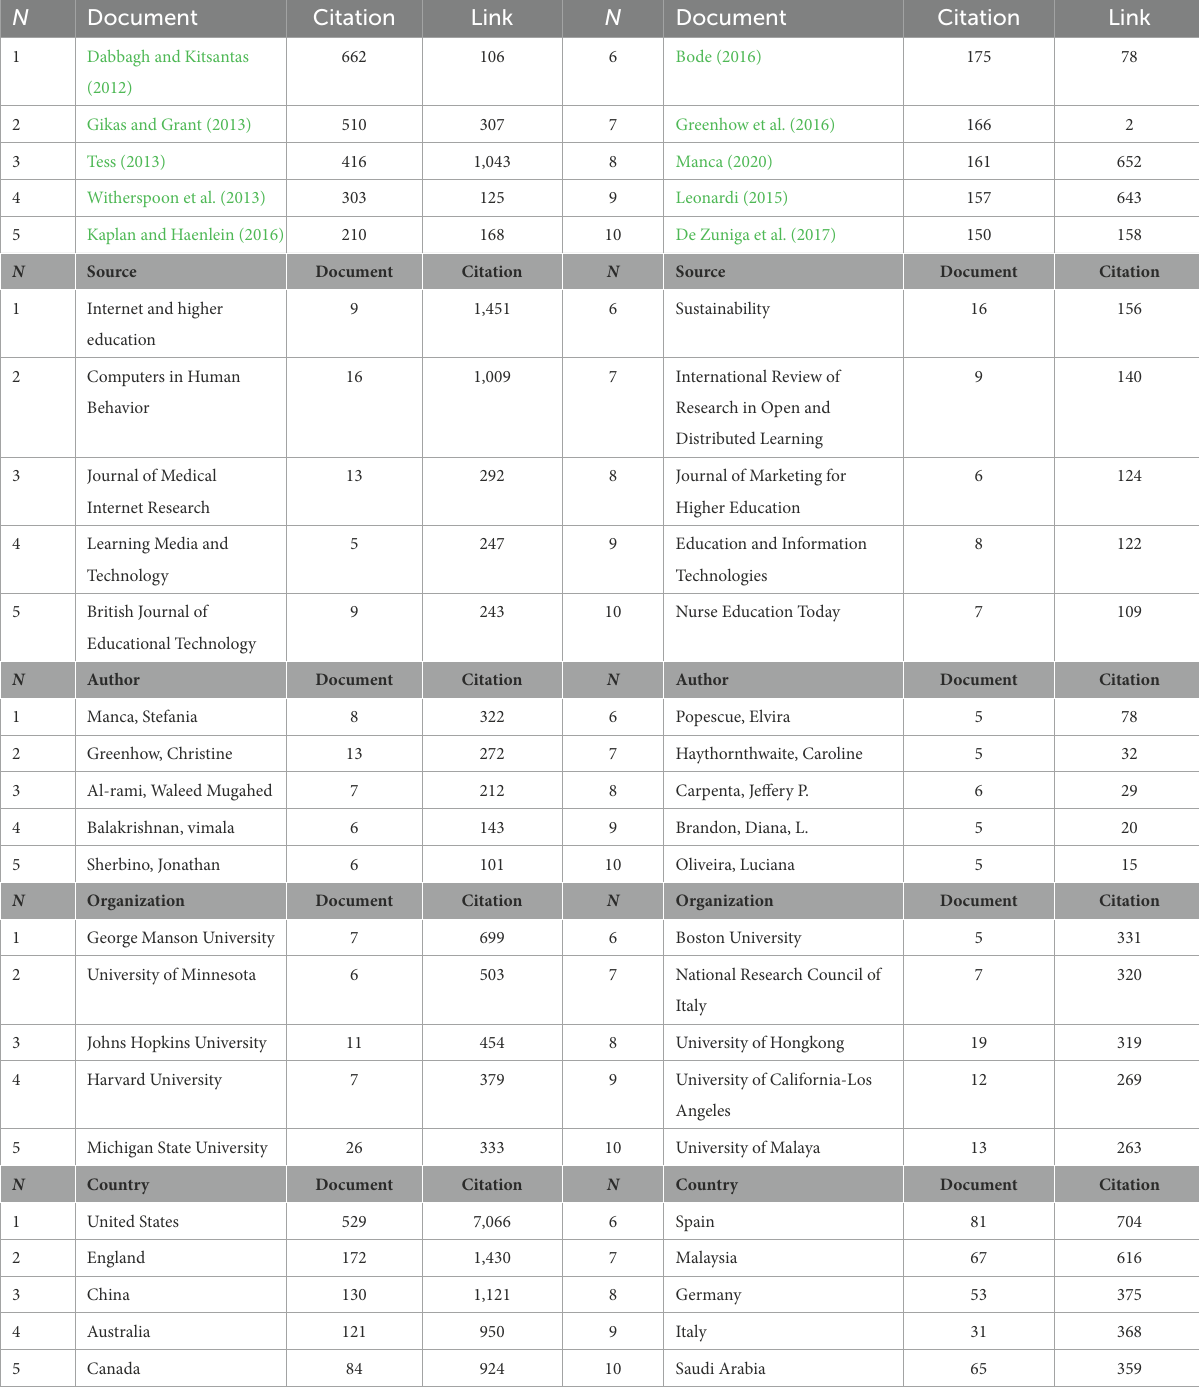
TABLE 6 Top 10 documents, sources, authors, organizations, and countries based on